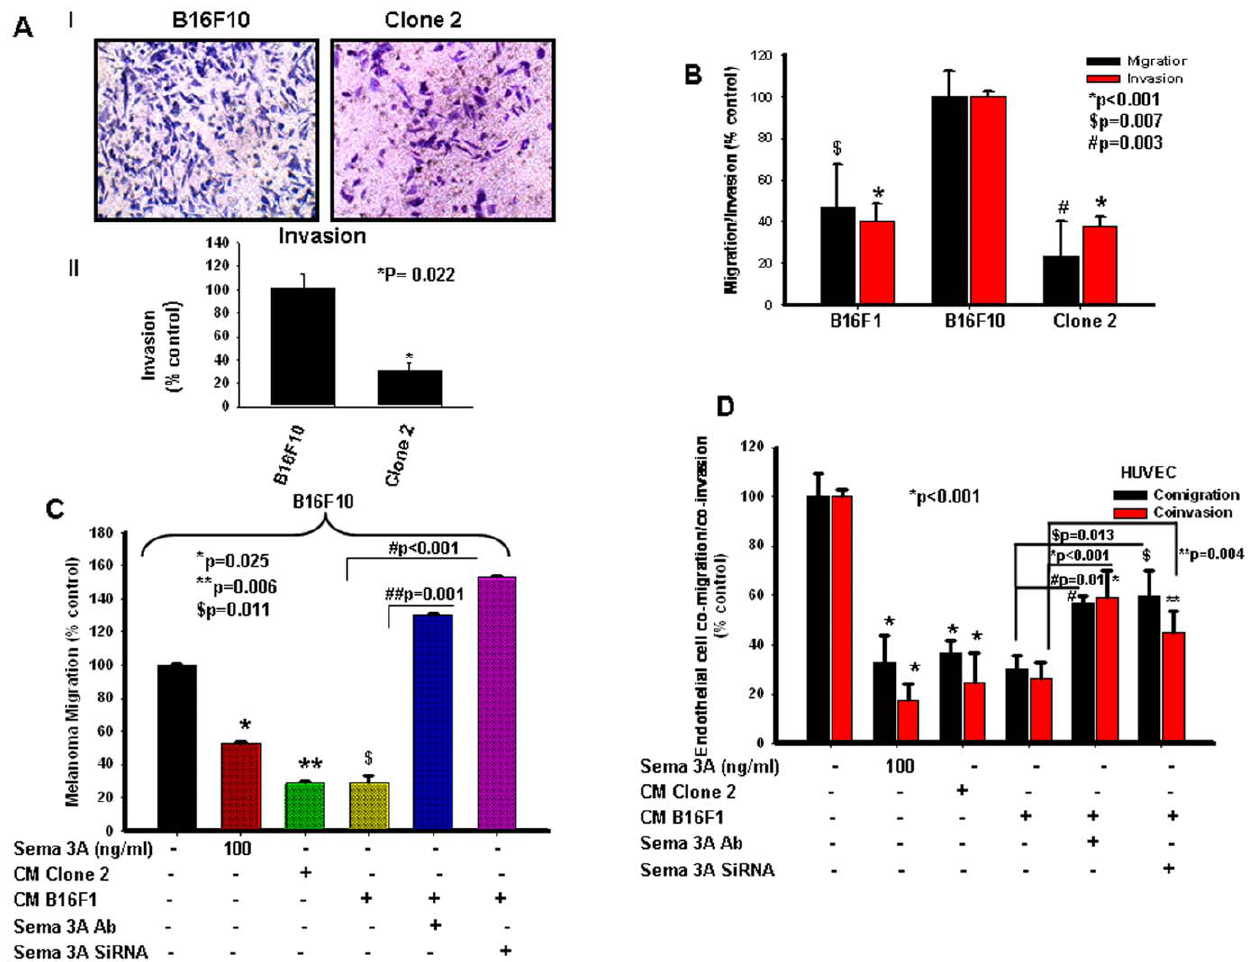
Figure 3. Sema 3A inhibits melanoma cell migration and invasion through autocrine and paracrine mechanisms. ( A ) Invasion assays were performed on matrigel coated invasion chamber. Cells (control or clone 2; 1 6 10 5 ) were plated on upper chamber. After 18 h, invaded cells